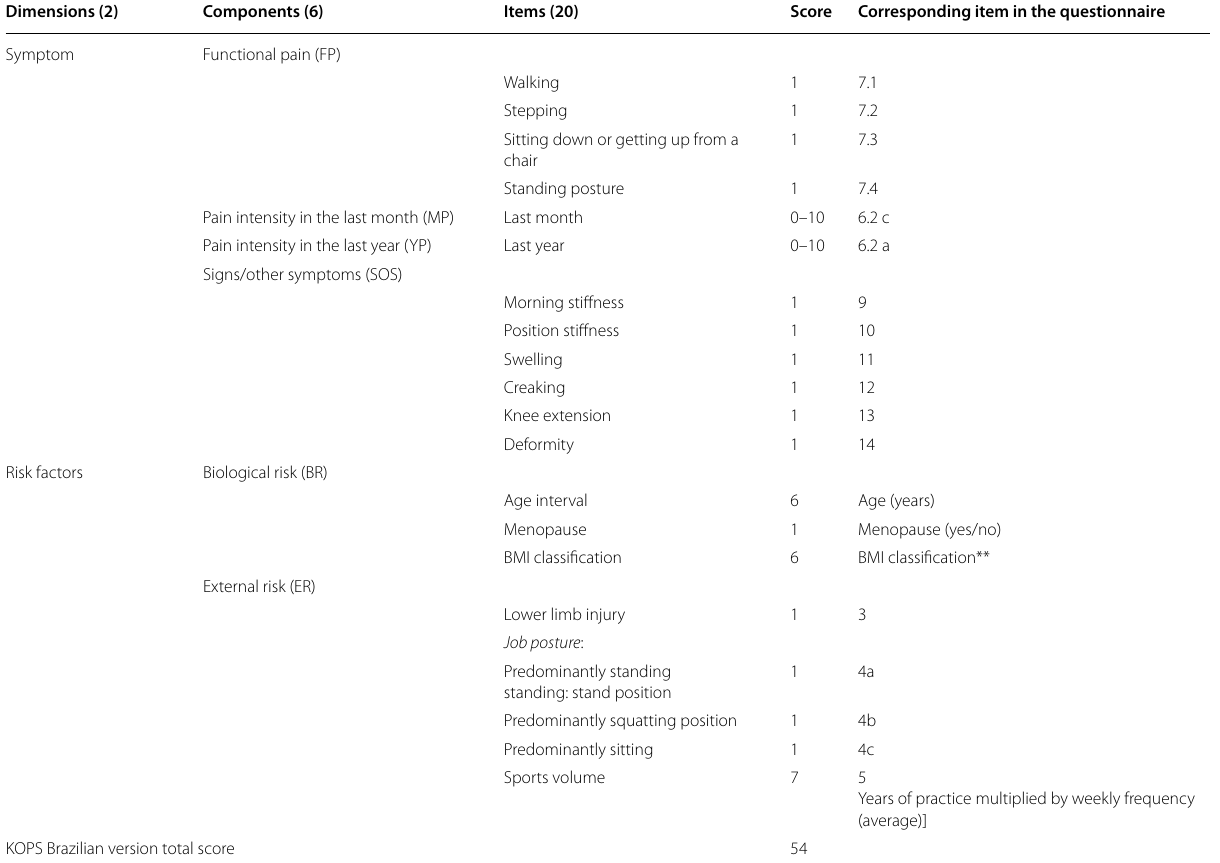
*0 ‑ Less than or equal to 39 years old; 1–40 to 49 years; 2–50 to 59 years; 3–60 to 69 years; 4–47 to 79 years; 5–80 to 89 years; 6 ‑ Greater than or equal to 90 years old. **1 ‑ Underweight; 2 ‑ Normal weight; 3 ‑ Overweight; 4 ‑ Grade 1 obesity; 5 ‑ Grade 2 obesity; 6 ‑ Grade 3